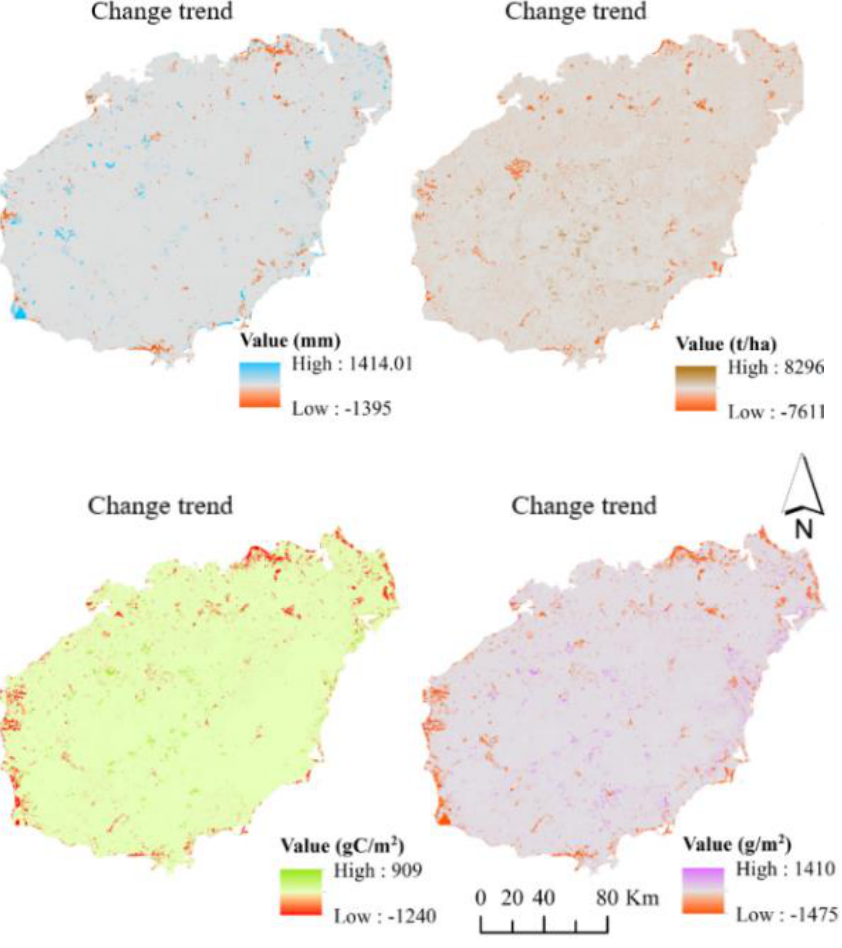
Figure 6. Trend distribution maps of average ecosystem services on Hainan Island from 1980 to 2015.